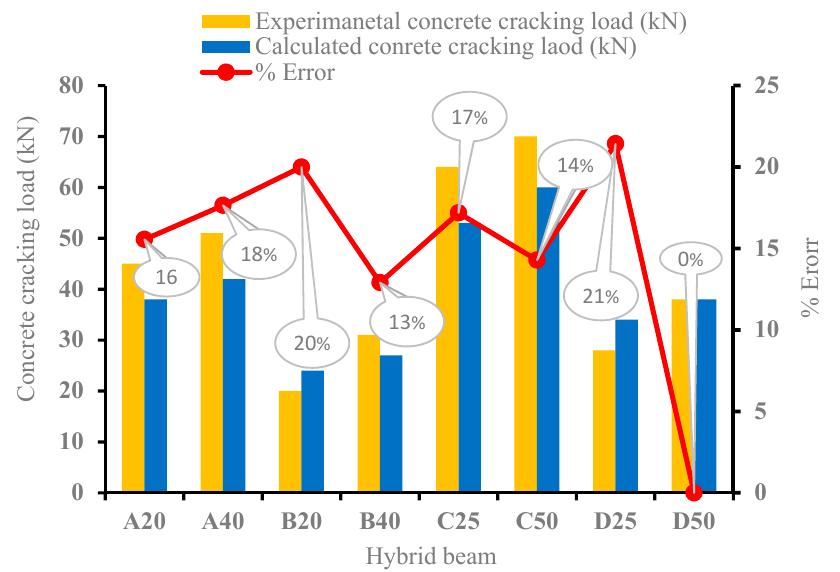
Figure 14. Experimental versus the calculated cracking load (P cr .).